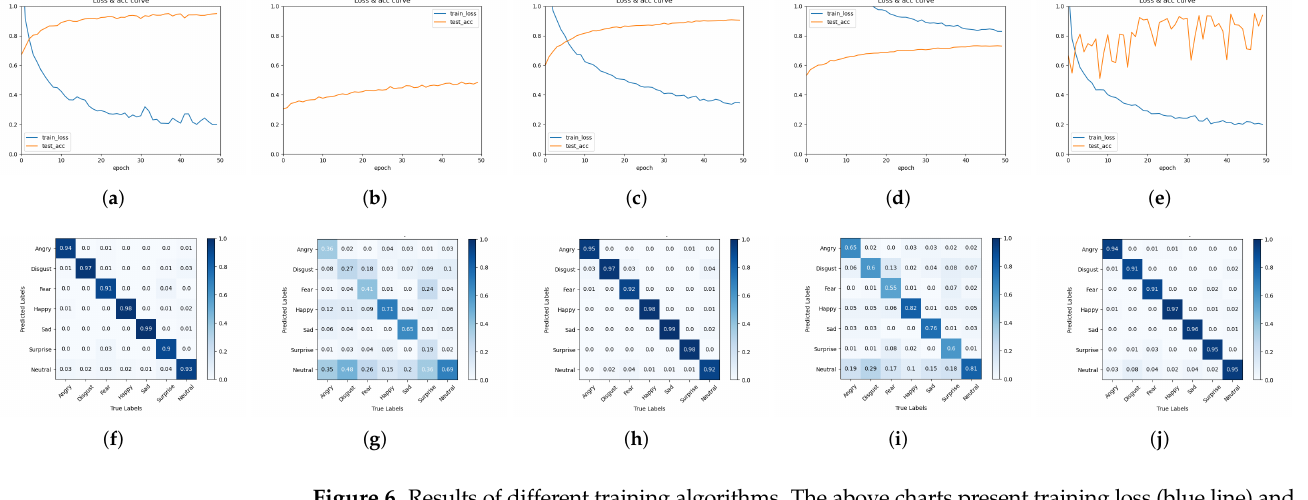
Figure 6. Results of different training algorithms. The above charts present training loss (blue line) and test accuracy (orange line); the bottom charts present the corresponding confusion matrix. ( a ) ACC and Loss Adam, ( b ) ACC and Loss SGD, ( c ) ACC and Loss RMSprop, ( d ) ACC and Loss Adagrad, ( e ) ACC and Loss Adamax, ( f ) matrix Adam, ( g ) matrix SGD, ( h ) matrix RMSprop, ( i ) matrix Adagrad, ( j ) matrix